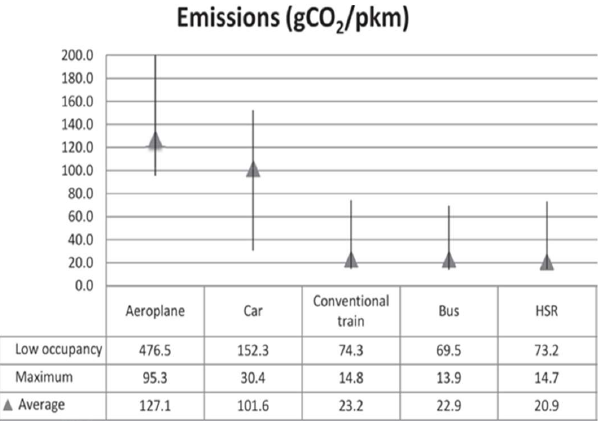
Figure 3. Greenhouse gas emissions for the Madrid-Barcelona route